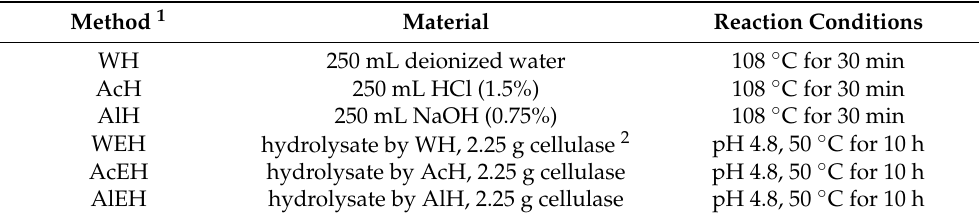
Table 1. Experimental parameters of different hydrolysis methods. Method 1 Material Reaction Conditions